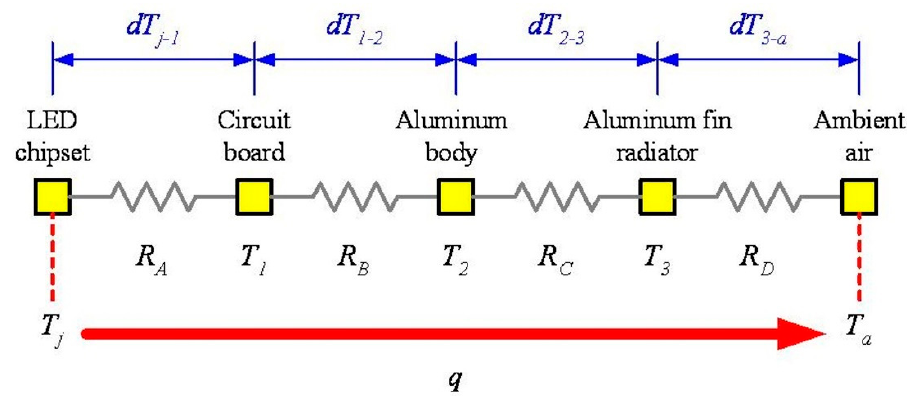
Figure 4. Schematic diagram of the thermal resistance of the LED lamp.